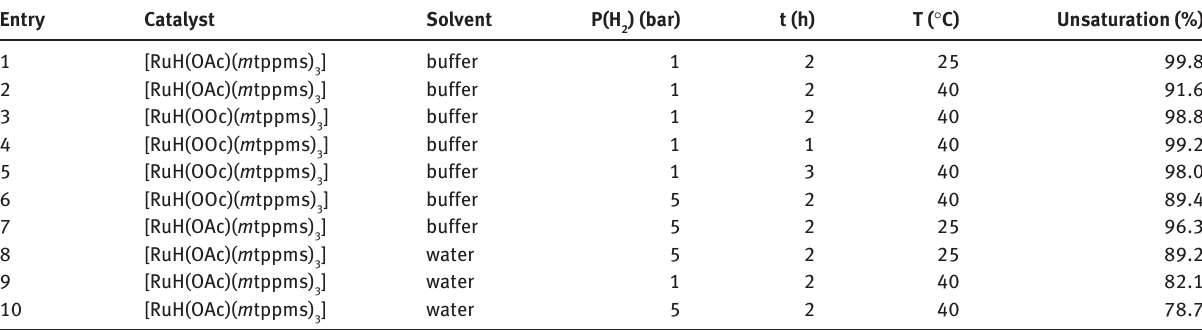
] and [RuH(OOc)( m tppms) 3